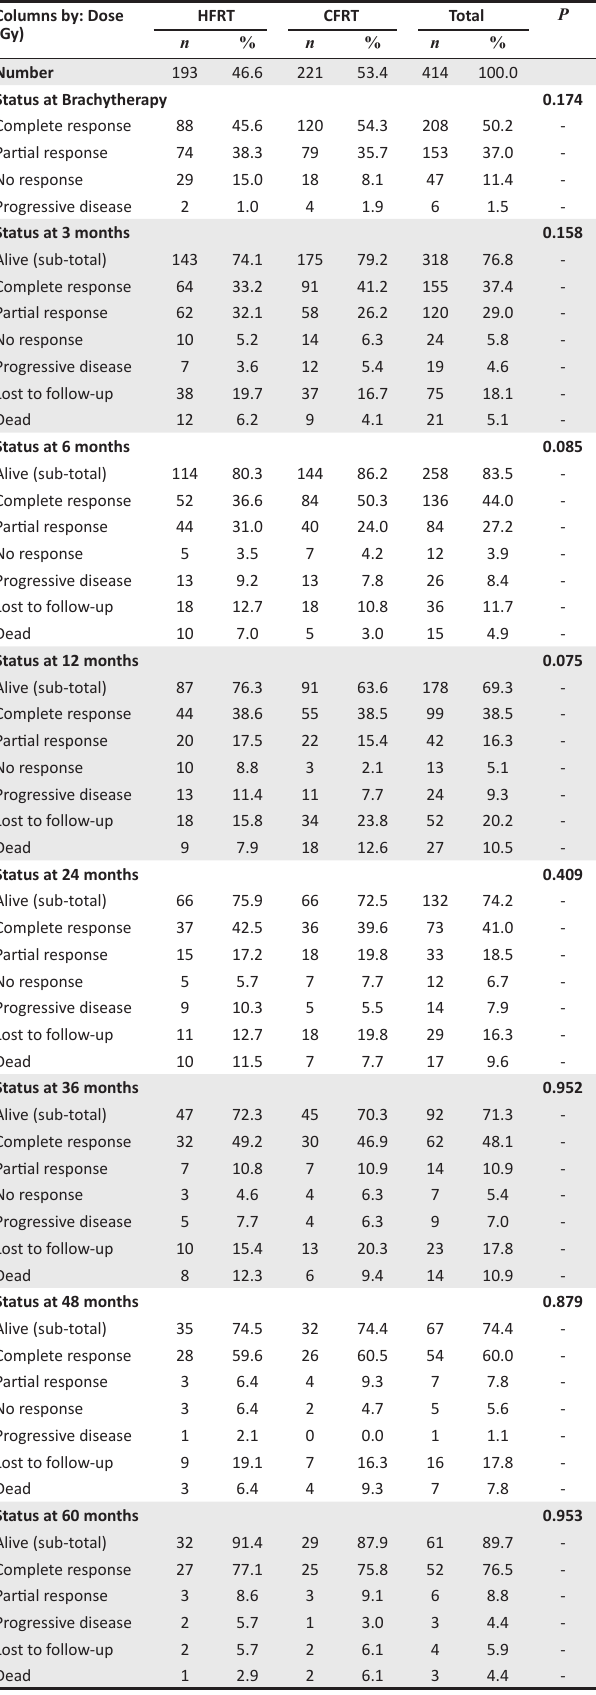
TABLE 3: Summary of toxicities at different follow-up periods. Dose